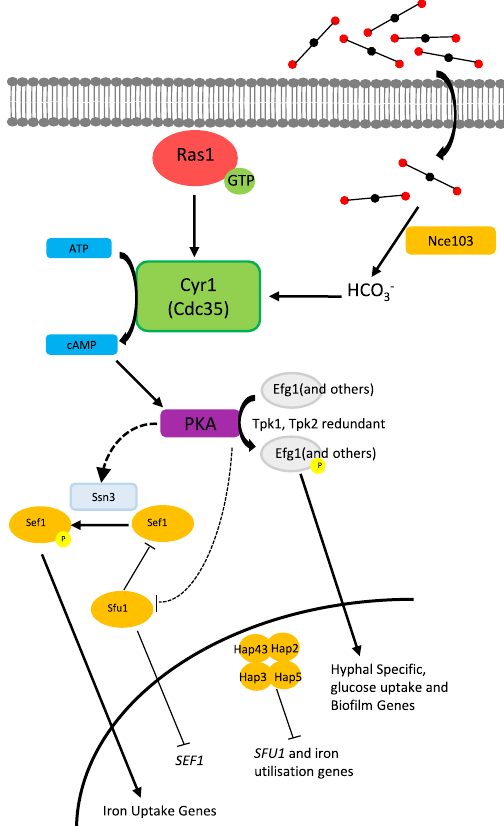
Fig. 10 Predicted model of the interplay between CO 2 signalling and iron homoeostasis in C . albicans bio fi lms on silicone surfaces. High environmental levels of CO 2 drive bio fi lm formation via the Ras1-Cyr1-PKA pathway in the same way as previously shown for hyphal morphogenesis in planktonic cells. This is accompanied by an increase in iron-scavenging capability by bio fi lm-associated cells. Our data are consistent with a CO 2 -mediated activation of PKA via Cyr1 resulting in increased abundance and activity of Sef1 in an Ssn3-dependent manner (this process may also involve the inhibition of Sfu1). Subsequent increased expression of iron uptake genes thus enables more effective scavenging of environmental